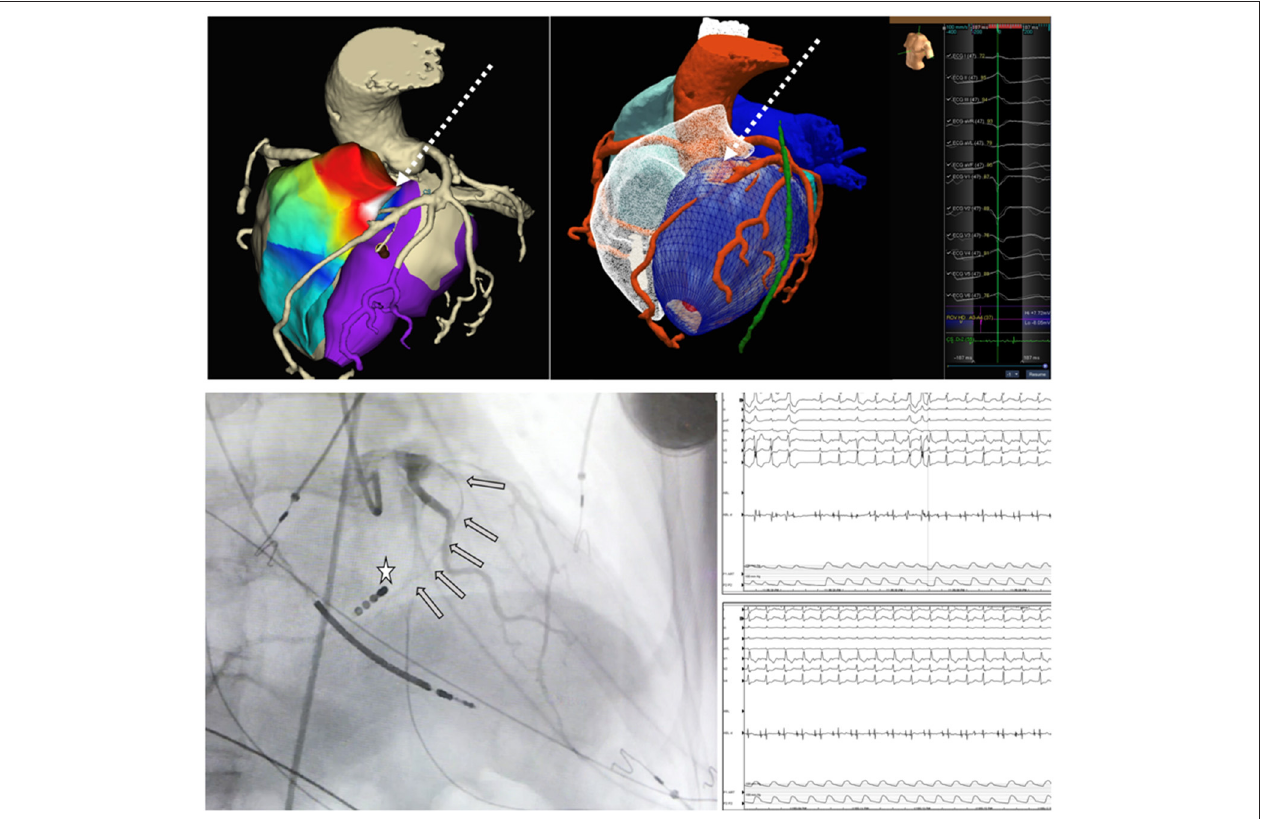
FIGURE 5 | Adapted from Roca-Luque et al. (30). Pace-map electroanatomical map (EAM) of right ventricle (RV) (anterior view) with the highest concordance with ventricular tachycardia morphology (92%) in the anterior RV septum. Ablation as unsuccessful from both right and left ventricle. EAM is merged with pre-procedural cardiac tomography (CT) scan and a septal artery is observed irrigating the area of best pace-map. Centre panel shows only CT scan with septal artery irrigating an area of intramural eptal scar (red) corresponding to the area of best pace-map. Bottom panels show septal alcolholisation of the culprit area according pre-procedural imaging The wire inside septal artery (grey arrows) is shown in front of catheter tip (white star) in the RV septum. After alcholisation at that region (bottom right panel) ventricular tachycardia